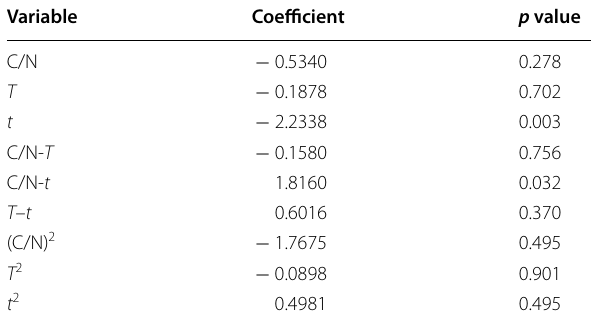
Table 6 Coefficient and p values for independent variables